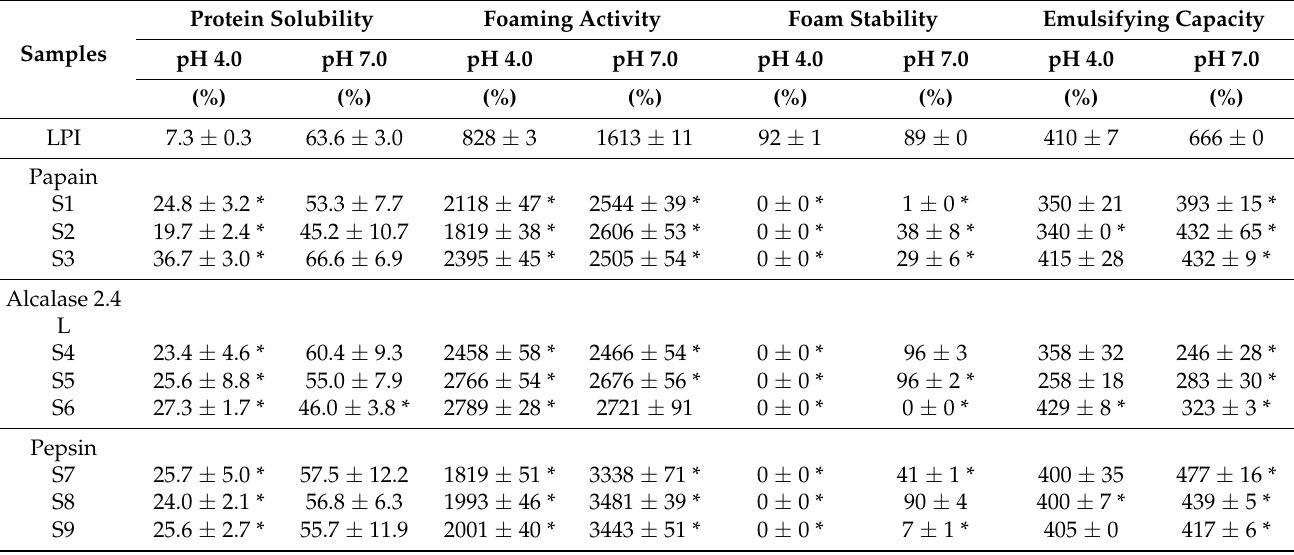
Table 6. Protein solubility, foam properties and emulsifying capacity of LPI and fermented LPI hydrolysates.